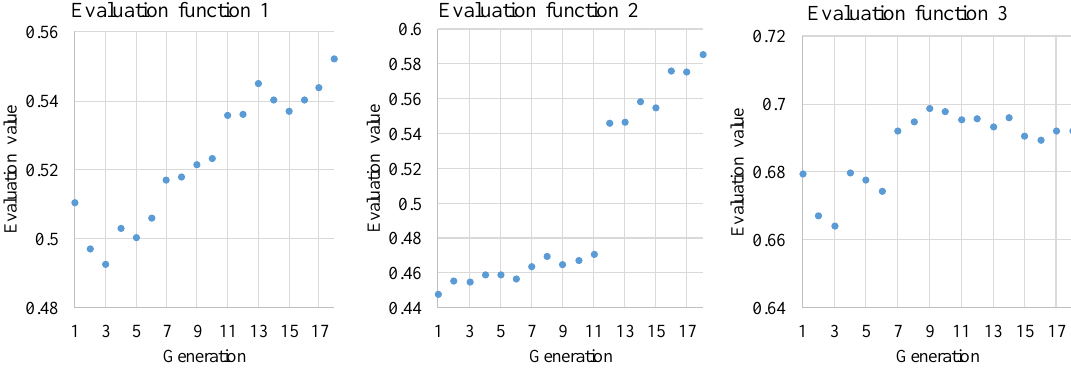
Figure 22. Evaluation value of each experiment (with 0.5 kg).